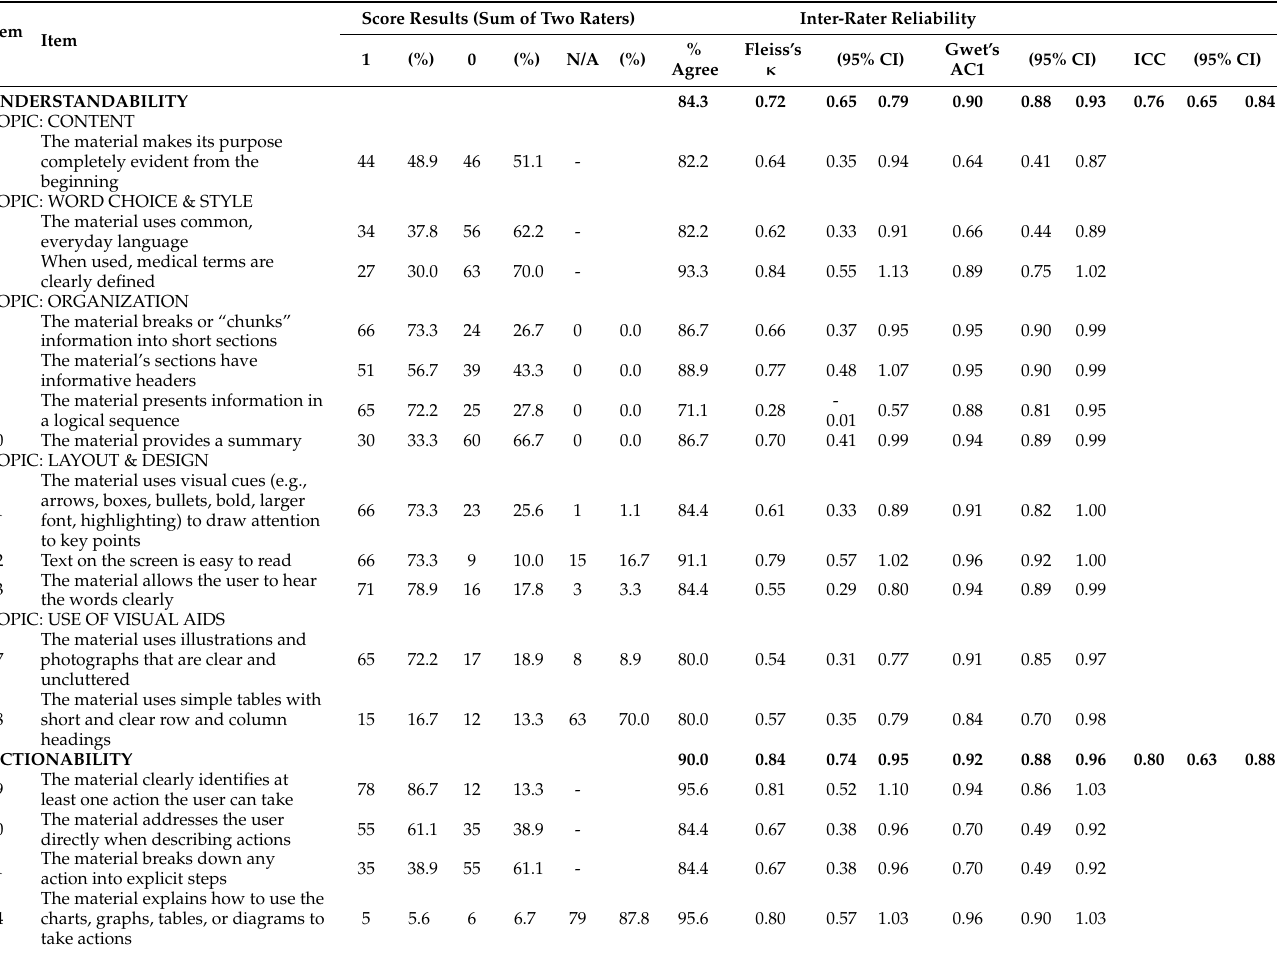
Table 2. Item-level reliability and validity results for items in the Japanese